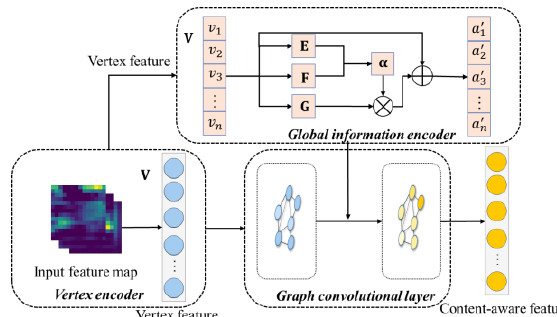
Figure 2. The flowchart of the dynamic GCN module. Given an input feature map, we first flatten the feature map to obtain v . After an attention mechanism encoder, the vertex feature n vertex features can adaptively transform the connection relation a ' . The feature vector. E , F and G are obtained by to obtain n fully connected network transformed. α is the product of E and. F Vector summation  and Vector multiplication  operations are involved in the attention mechanism encoder.